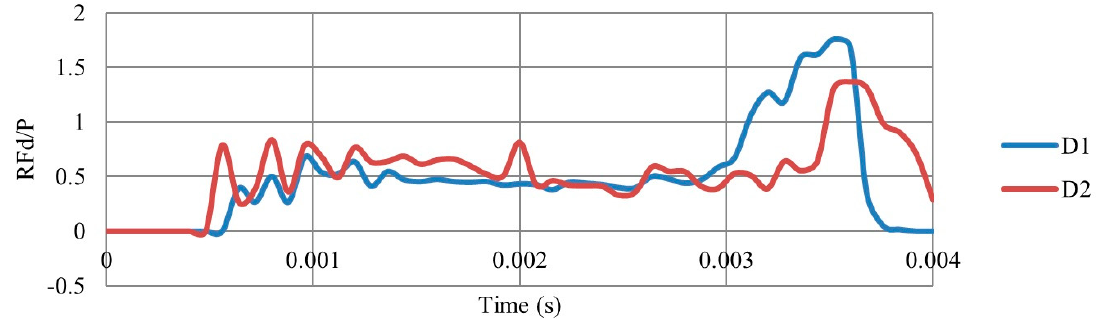
Figure 7. Ratio of the reaction force to the applied load (RFd / P) with respect to time, for an auxetic core loaded in two di ff erent directions D1 and D2, (t = 0.75 mm, L = 5 mm, t / L = 0.15, θ = 60 ◦ , AL2 grade). It shows that direction D1 (with higher auxetic behaviour (Table 4), gives less RFd / P.